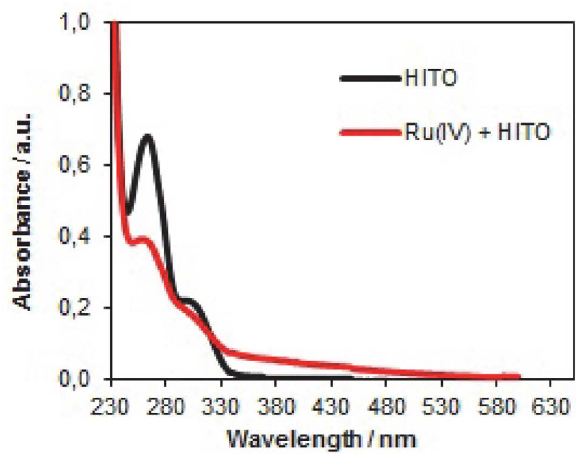
Fig 4. Absorbance spectra of reagent and complex Ru(IV) with HITO.